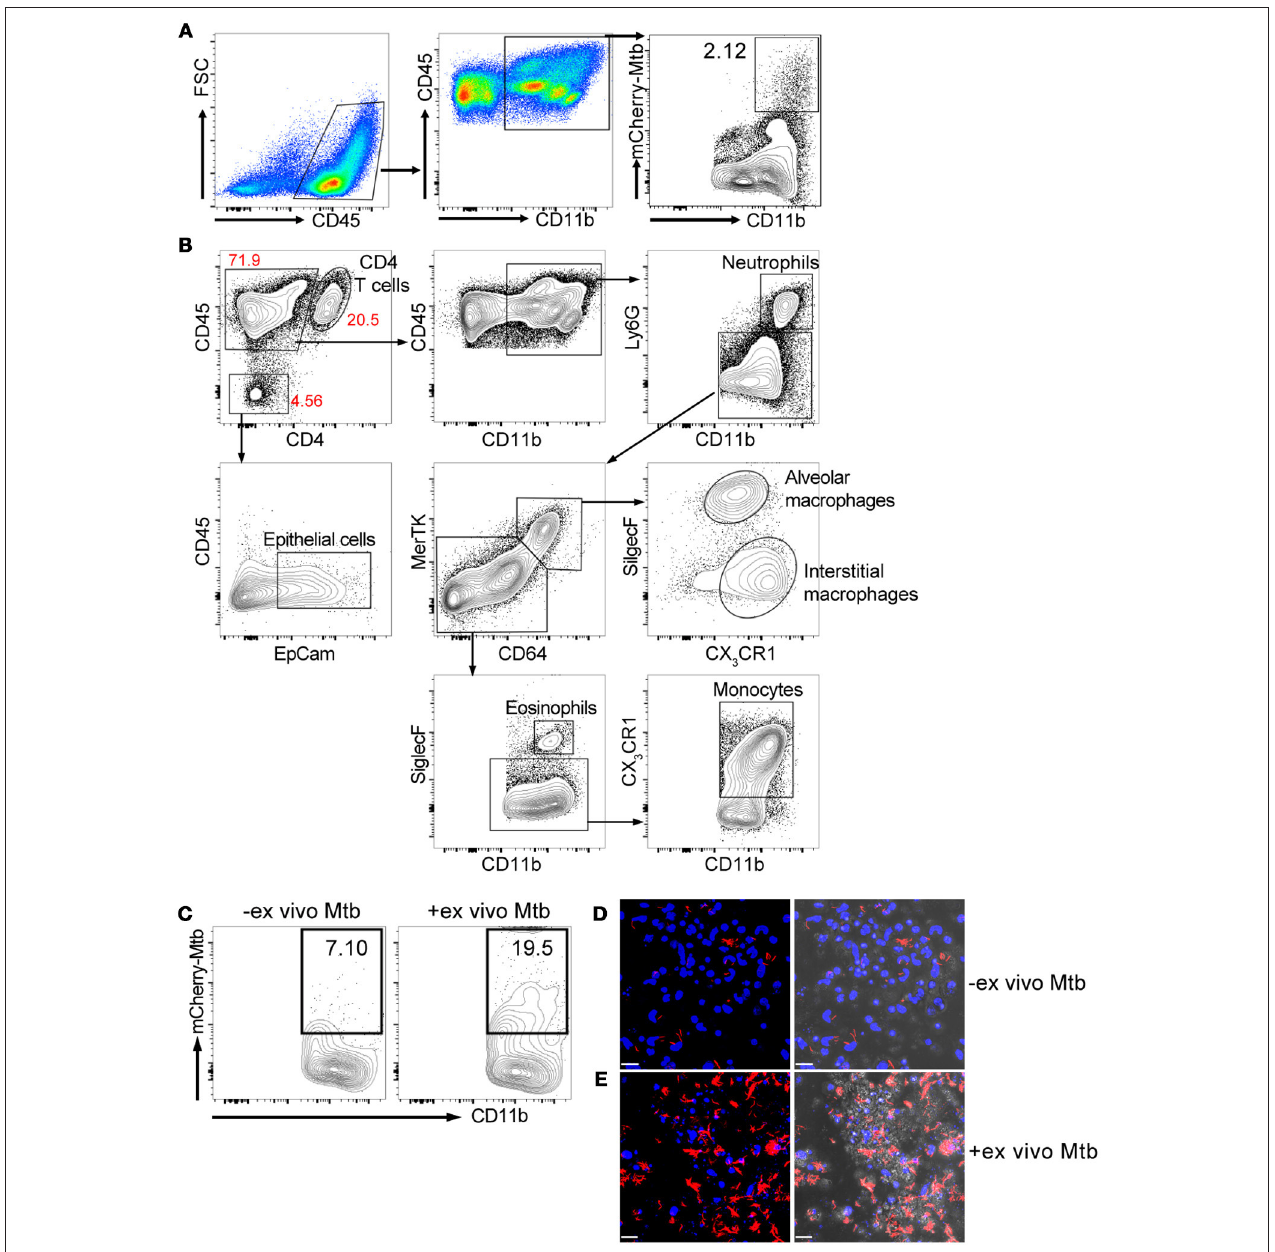
FIGURE 1 | Ex vivo challenge with the fluorescent Mtb strain increases the numbers of infected myeloid cells. Mice were infected with ∼ 1,000 CFU Erdman( smyc’ ::mCherry) for 3 weeks. Lung single cell suspensions were isolated for the analysis. (A) Gating strategy and flow cytometric analysis of percentage of Mtb-infected myeloid cells (CD45 + CD11b + ) in the mouse lung after 3 weeks infection. (B) Multi-color flow cytometry analysis of myeloid populations in Mtb infected mouse lung at 3 weeks post infection. (C) Flow cytometry analysis of percentage of Mtb-infected lung myeloid cells before and after ex vivo challenge with mCherry Mtb at MOI 0.1 for 24h. (D,E) Confocal images of cultured lung cells isolated from mCherry Mtb-infected mice without (D) or with (E) ex vivo challenge. The left panels of (D,E) show the fluorescent images and the right panels show the same fluorescent images overlaid with the brightfield images. Scale bar = 25 µ m in (D,E) . The experiments were repeated at least two times.